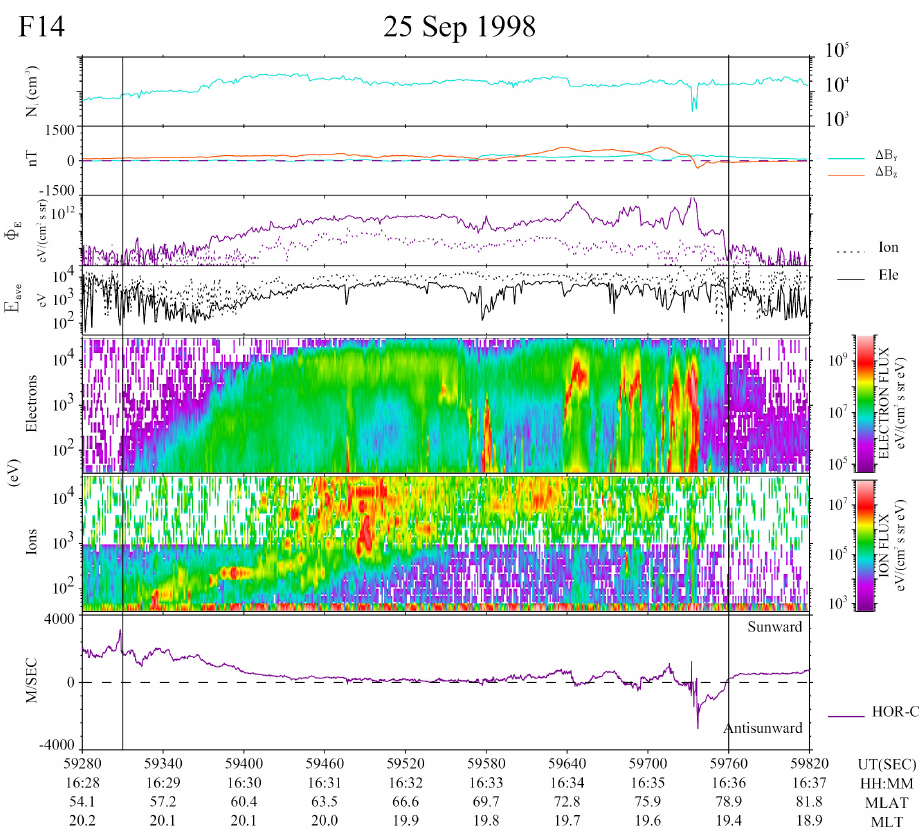
Fig. 13. As Fig. 10, but within the 16:28–16:37 UT interval on 25 September 1998 from the DMSP F14 pass over auroral latitudes.